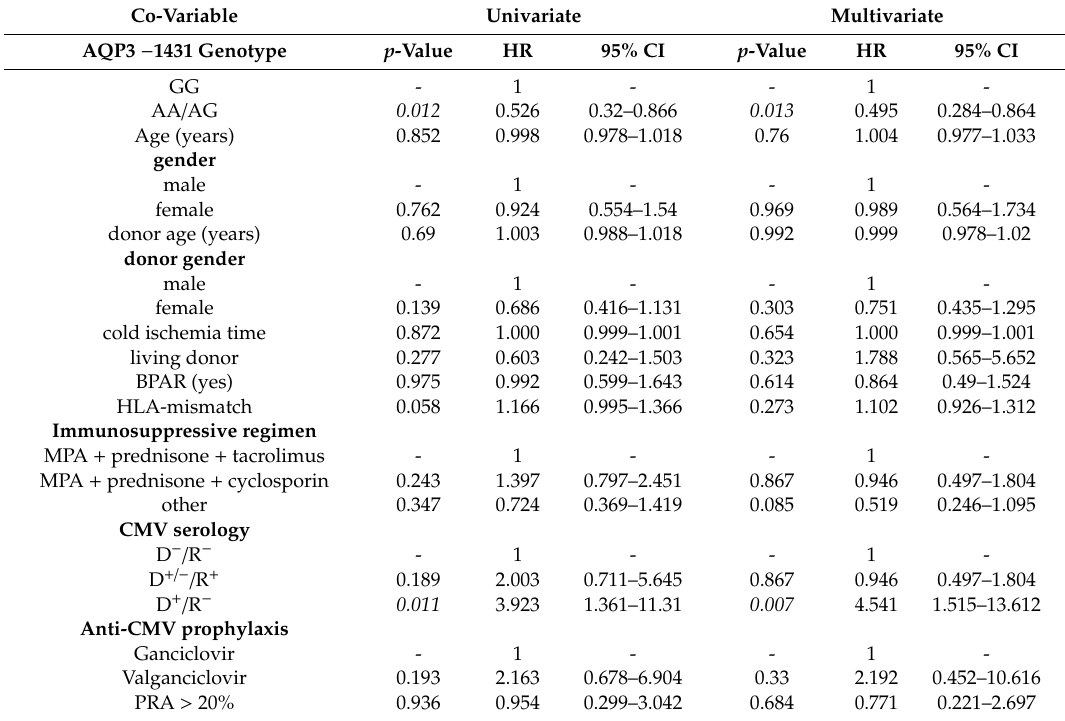
Table 5. Multivariate COX-regression analysis of CMV infection over 360 days after transplantation: HR, odds ratio point estimates, 95% CI, and p -values (two-sided) are